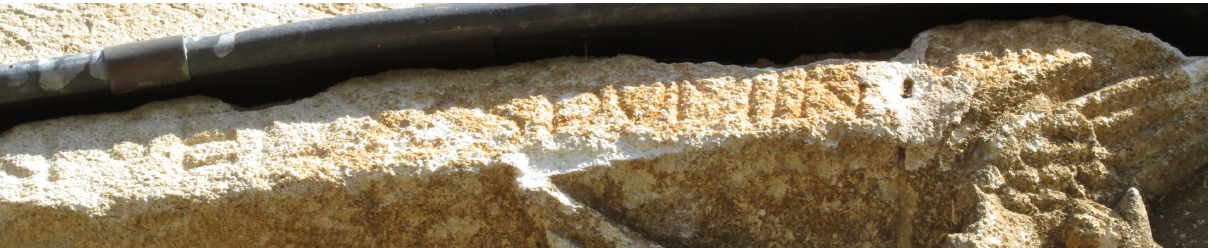
Figure 19. [A]NGELUS DOMIN[I], detail of archivolt, west façade, Saint-Martin Church , 12th c., Besse, Dordogne, Nouvelle-Aquitaine, France. ©Author.